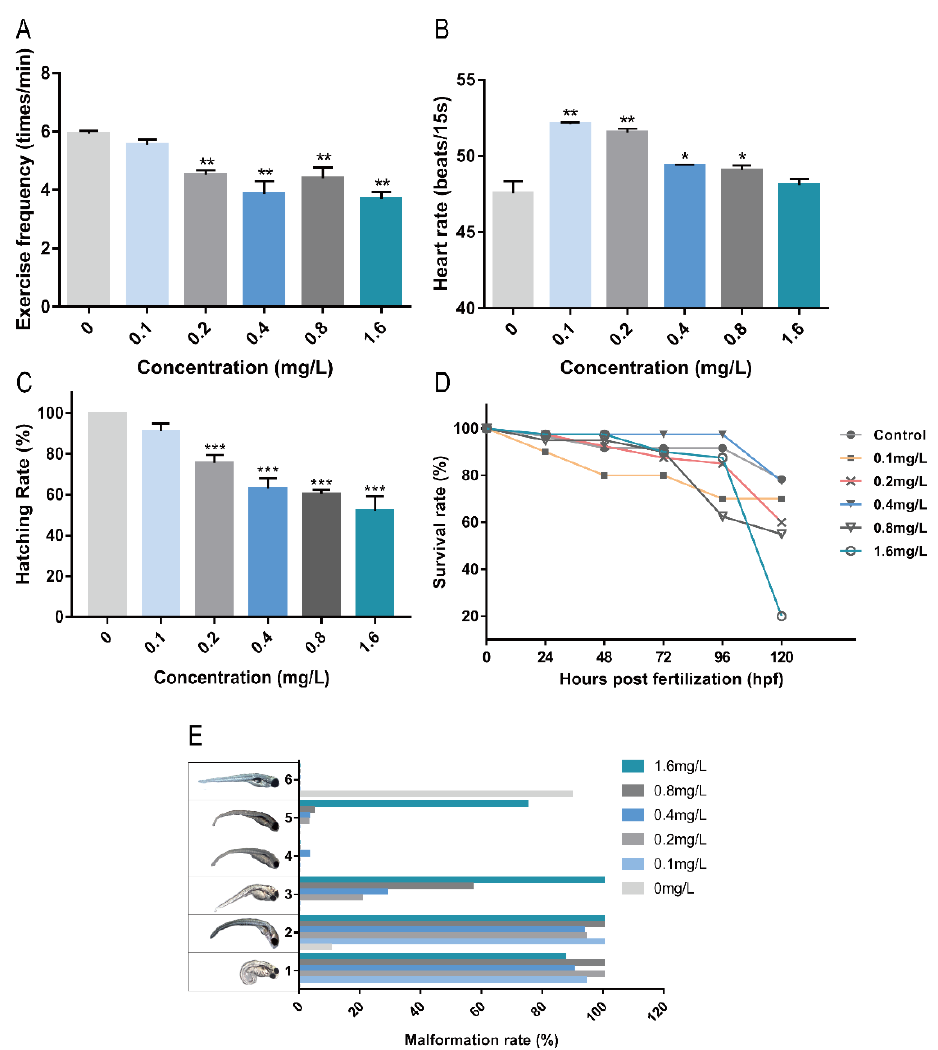
Figure 1. The effects of different concentrations of Pb 2+ on zebrafish embryos. ( A ) 24 hpf exercise frequency; ( B ) 48 hpf heart rate; ( C ) 57 hpf hatching rate; ( D ) 120 hpf survival rate; ( E ) 120 hpf Malformation rate (1, spinal curvature; 2, absence of swim bladder; 3, pericardial cavity edema; 4, pigment deficiency; 5, cerebral hemorrhage; 6, normal juvenile zebrafish). (* p < 0.05, ** p < 0.01, *** p < 0.001, n = 15, repeat three times).